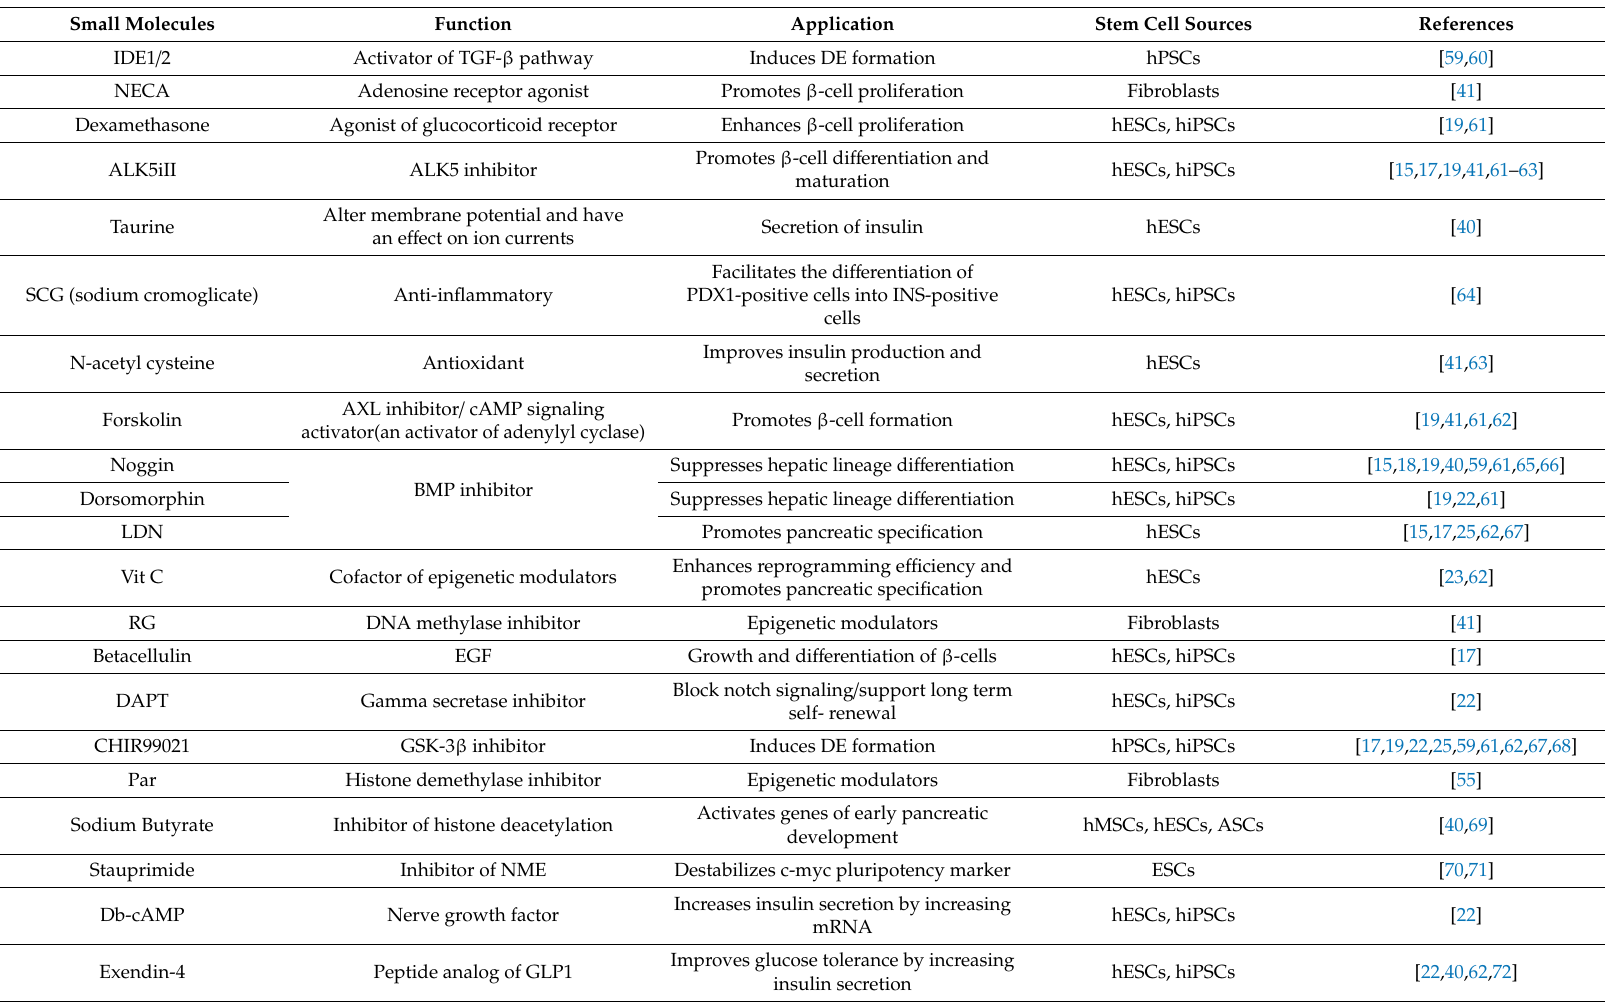
Table 3. Small molecules involved in various stages of β -cell di ff erentiation from stem